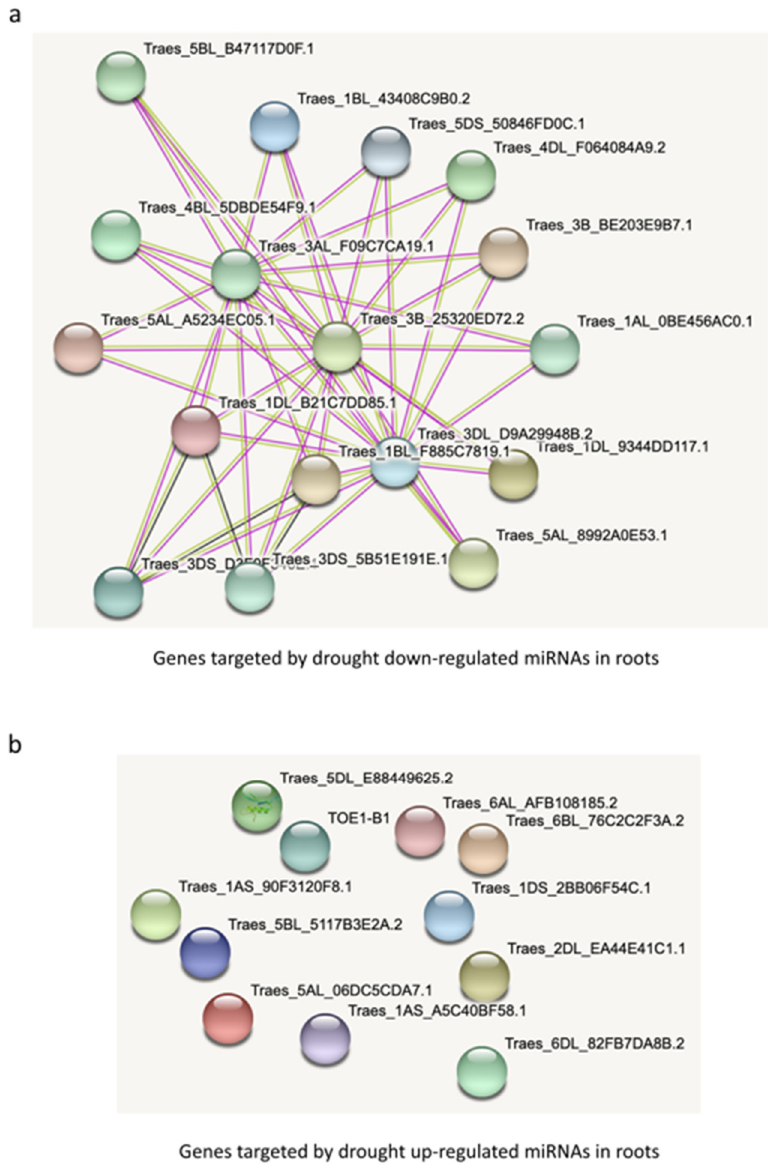
Figure 7. Network analysis of ( a ) target genes by drought-downregulated miRNAs and ( b ) drought- upregulated miRNAs in roots.